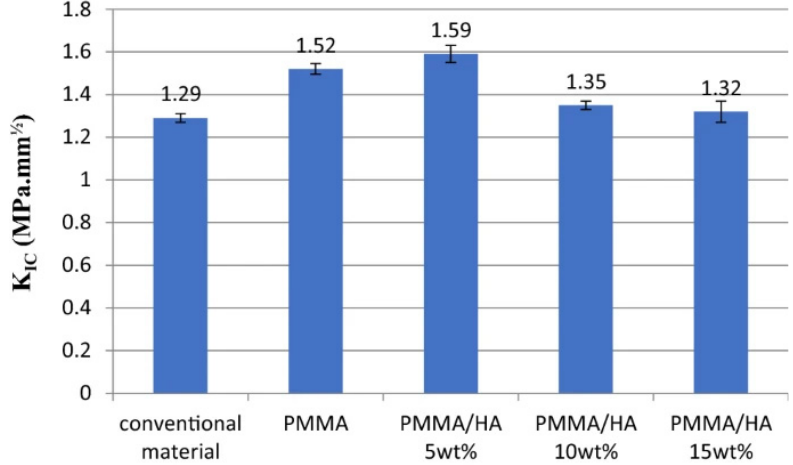
Figure 8. Effect of filler loading on the fracture toughness of PMMA/HA nanocomposite compared to the conventional material and neat PMMA. Reprinted from ref. [9], copyright 2020, MDPI.